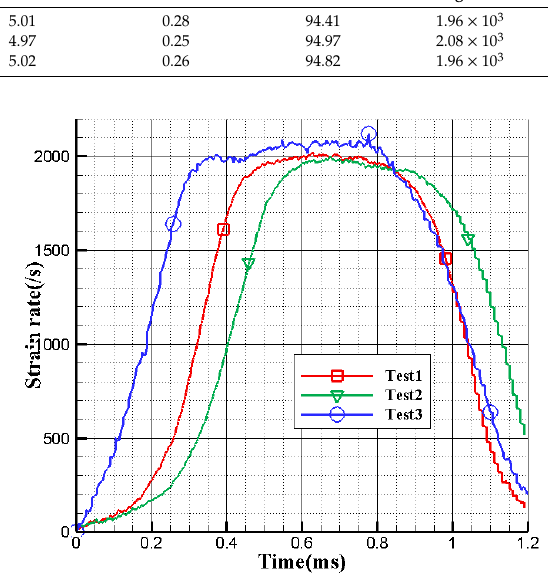
Figure 11. Strain rate curve at strain rate 2.0 × 10 3 s − 1.